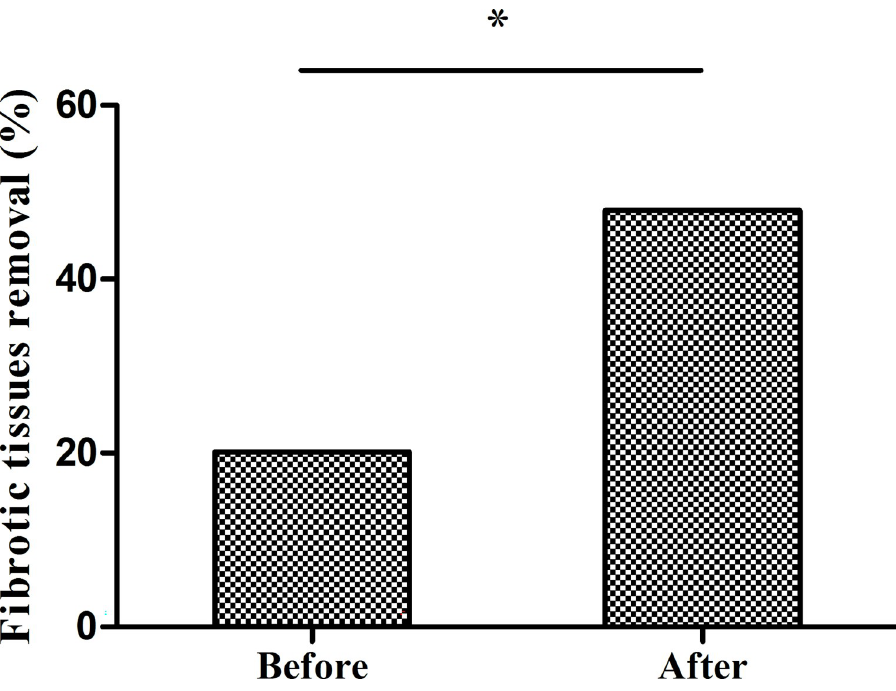
Fig 4. Handling of fibrotic and necrotic tissues during open surgery before and after program implementation. Before program implementation, only 20.1% of surgeries involved removing necrotic and fibrotic tissue. After program, implementation, the proportion increased to 47.9%. ( � p < 0.001 by the chi-square test).